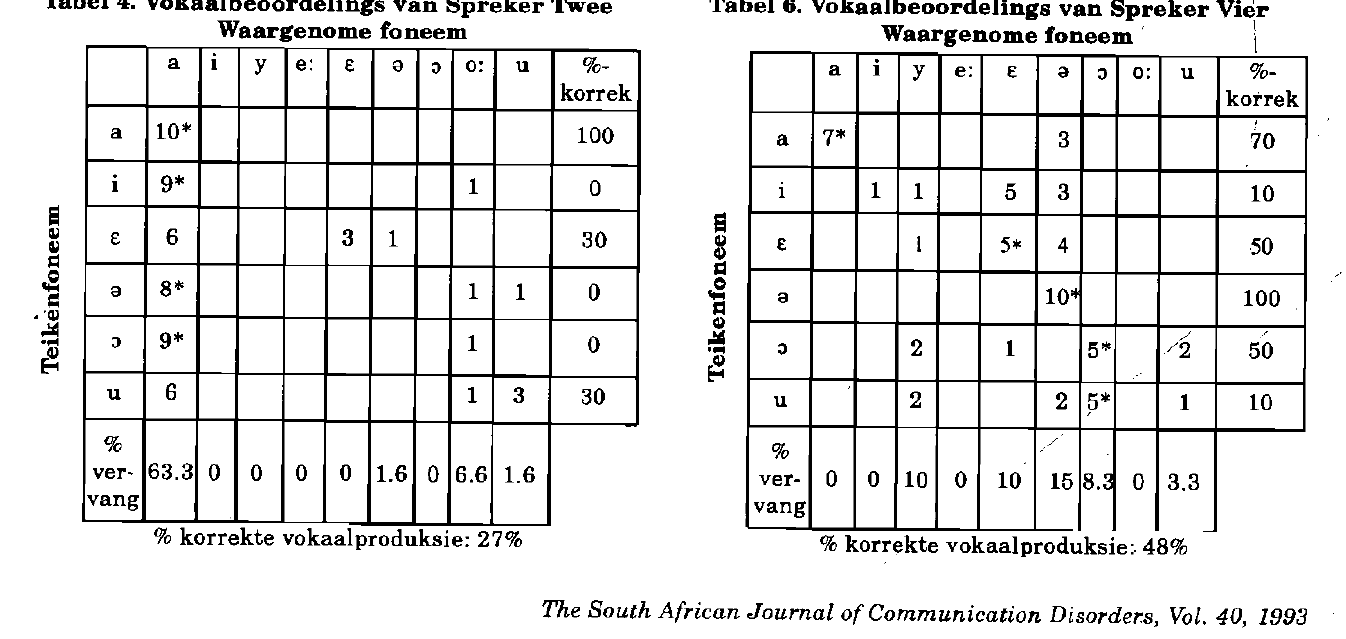
Tabel 4. Vokaalbeoordelings van Spreker Twee Waargenome foneem